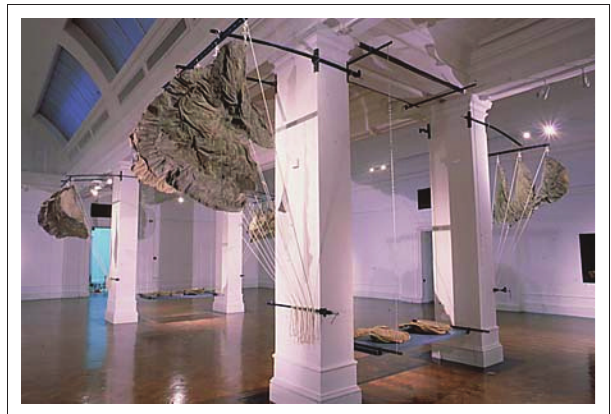
FIGURE 1: Heathen Wet Lip installation by Alan Alborough.